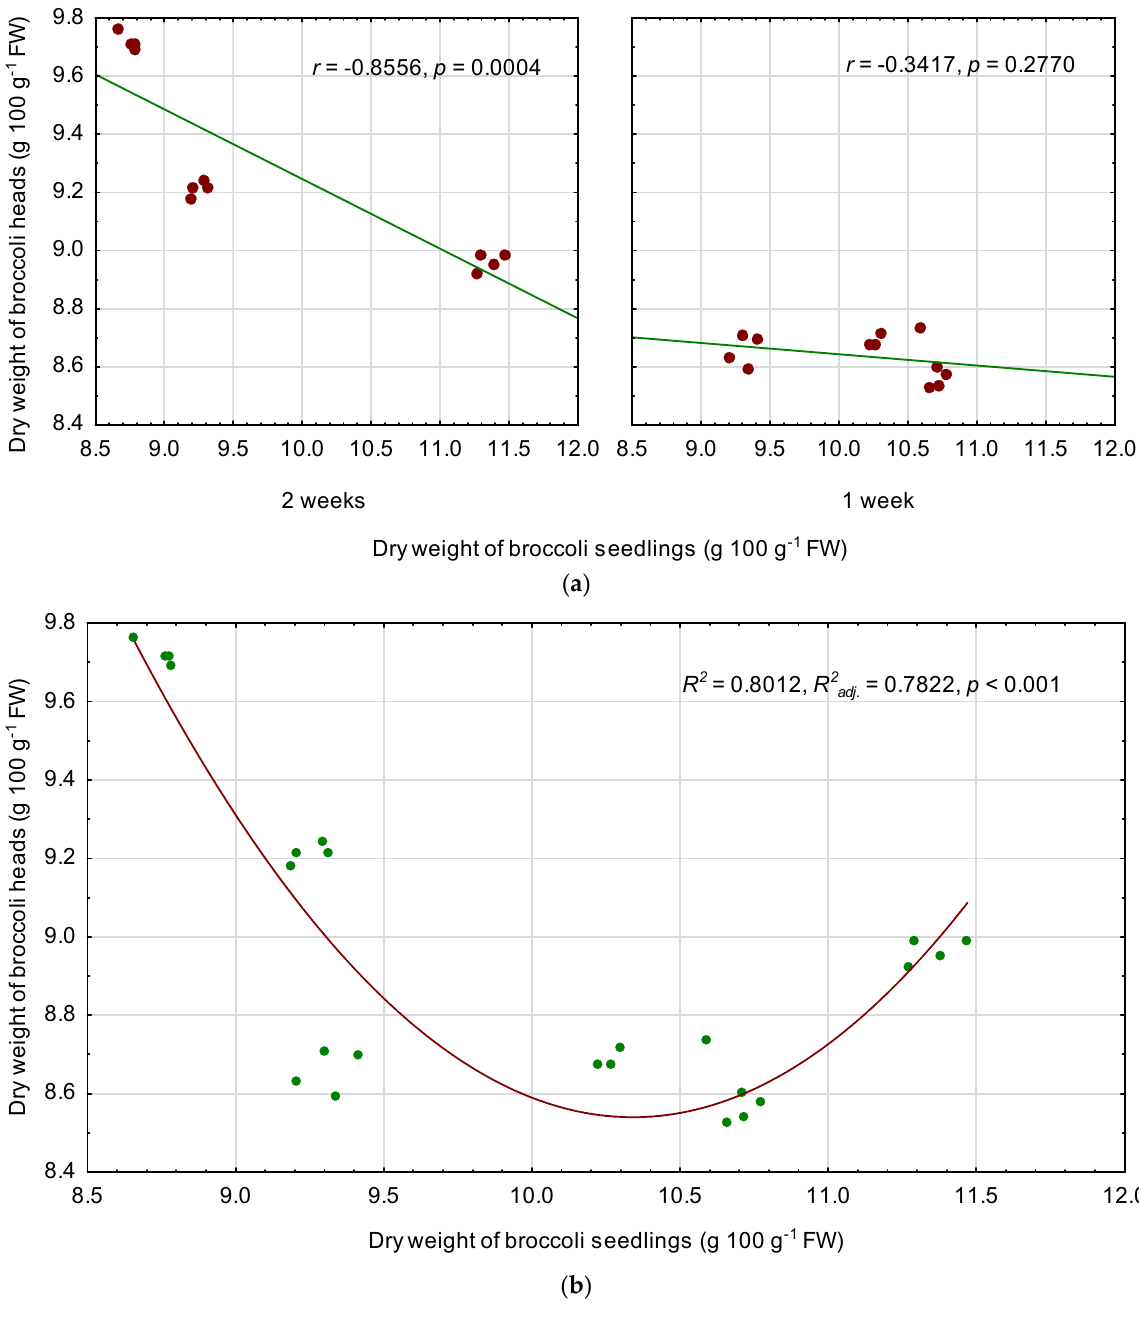
Figure 2. Linear relationship between dry weight (DW) of broccoli seedlings and DW content of fully mature broccoli heads, separately for temperature duration ( a ), and polynomial regression model for DW content of broccoli heads depending on the DW content of the seedlings ( b ). r —Pearson correlation coefficient, R 2 —coefficient of determination, R 2 adj. —adjusted coefficient of determination, p —probability